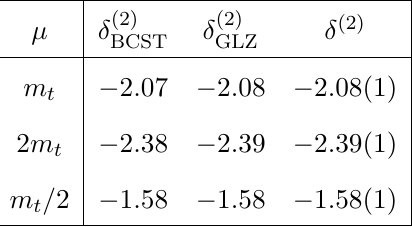
Table 1 . Comparison between our calculation of the second-order correction to the top-quark width ( δ (2) ), as a percentage of the LO result of 1 . 4806 GeV ( m t = 172 . 5 GeV ), and previous computations of the same quantity from Gao et al. [34] ( δ (2)